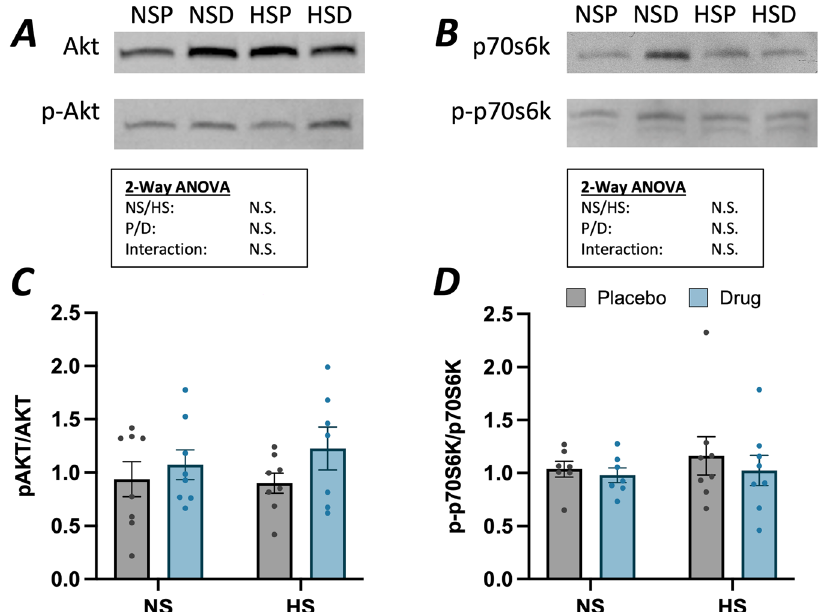
Fig. 4 Activated levels of Akt and p70s6k protein content in the tibialis anterior. A Representative immunoblot of total Akt and phosphorylated Akt and C ratio of p-Akt to Akt levels. B Representative immunoblot of total p70s6k and phosphorylated p70s6k and D ratio of p-p70s6k to p70s6k. Two-way ANOVA revealed no effect of suspension or signi fi cant activation of pAkt/Akt. There were no effects of either suspension or drug in p -p70s6K/p70s6K. Posthoc Tukey ’ s tests revealed no differences between any groups. Data are presented as mean ± SEM, n = 7 – 9 mice/group; α =